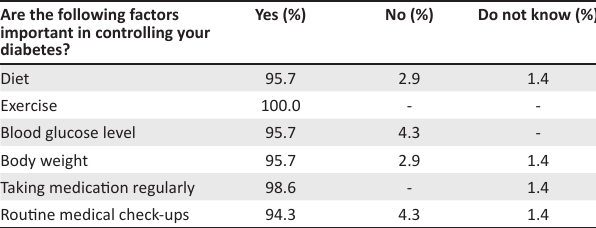
TABLE 1: Participant responses regarding the importance of different factors in controlling diabetes at the Outpatient Department at the National District Hospital in Bloemfontein, South Africa.